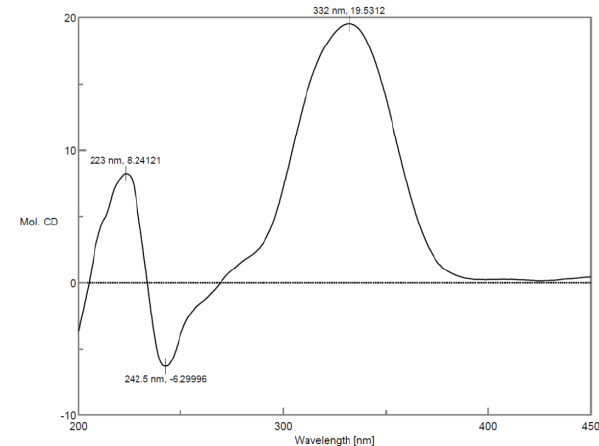
Figure 5. CD spectrum of compound 2 .